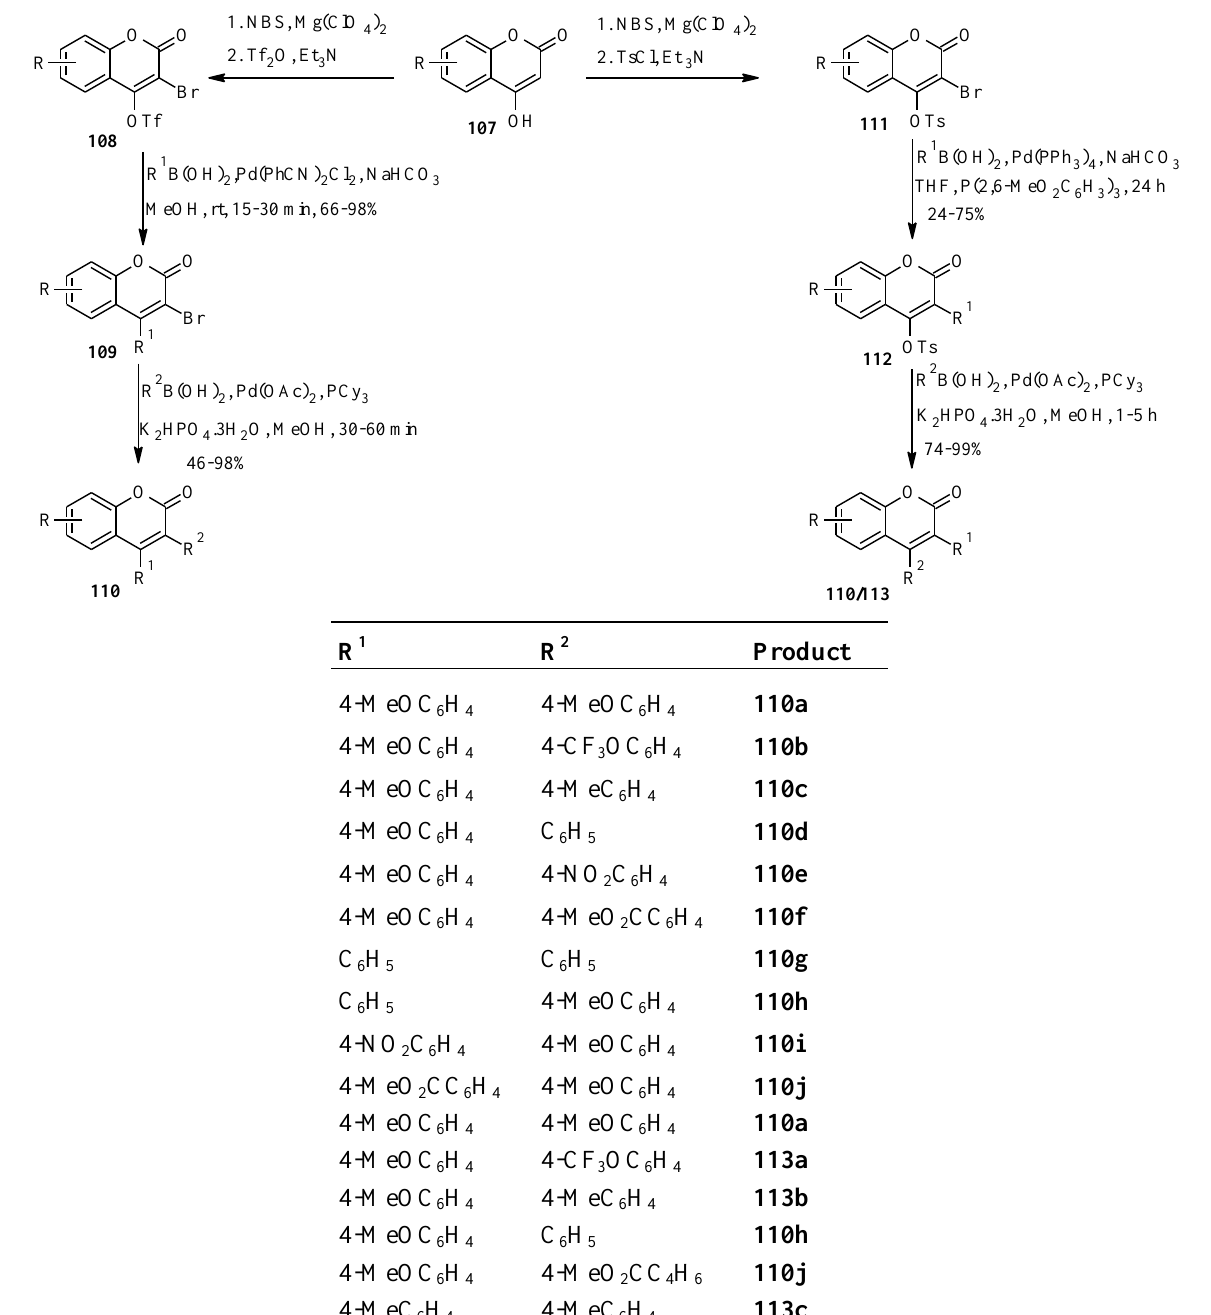
Scheme 29. Synthesis of 3-arylcoumarins